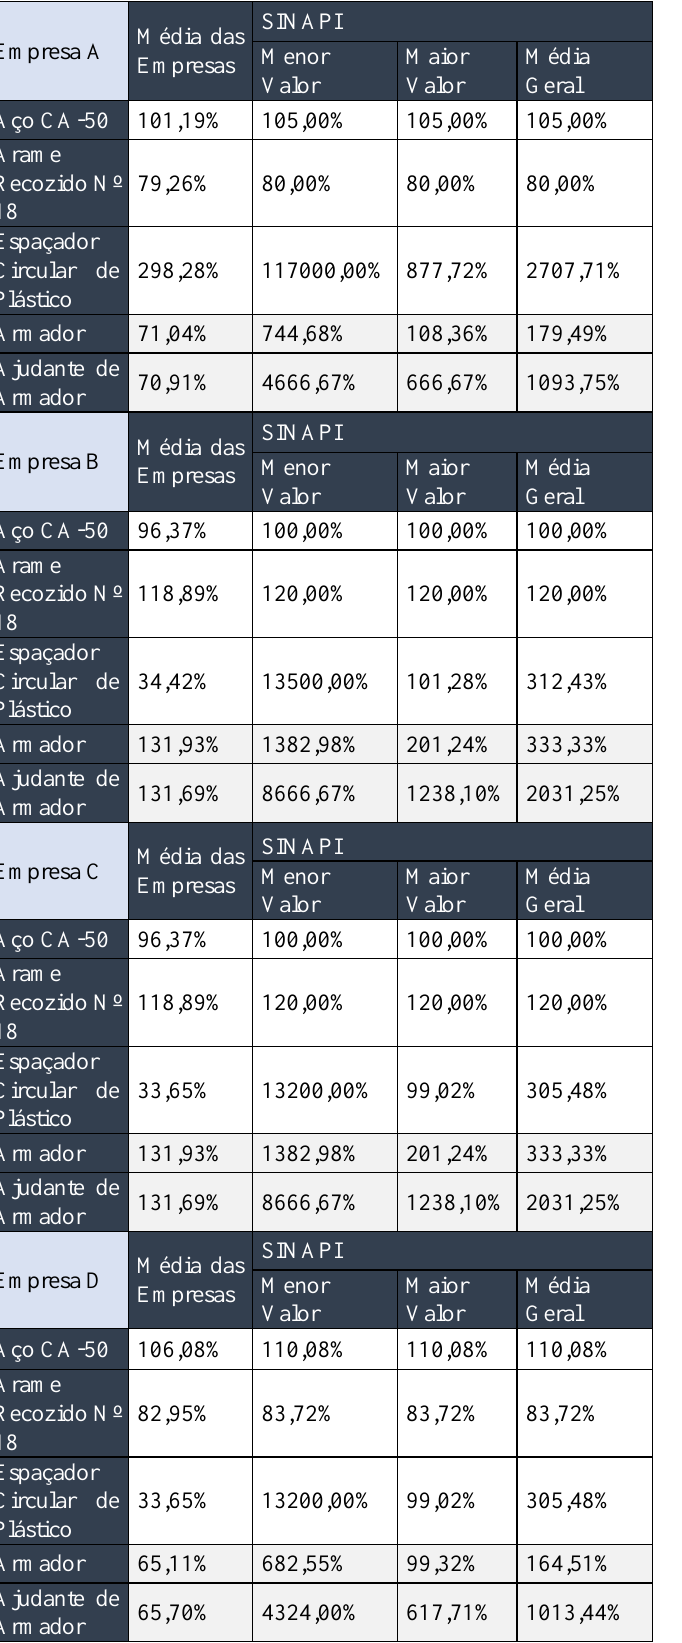
Tabela 7: Análise percentual dos índices de armação (Média e SINAPI).